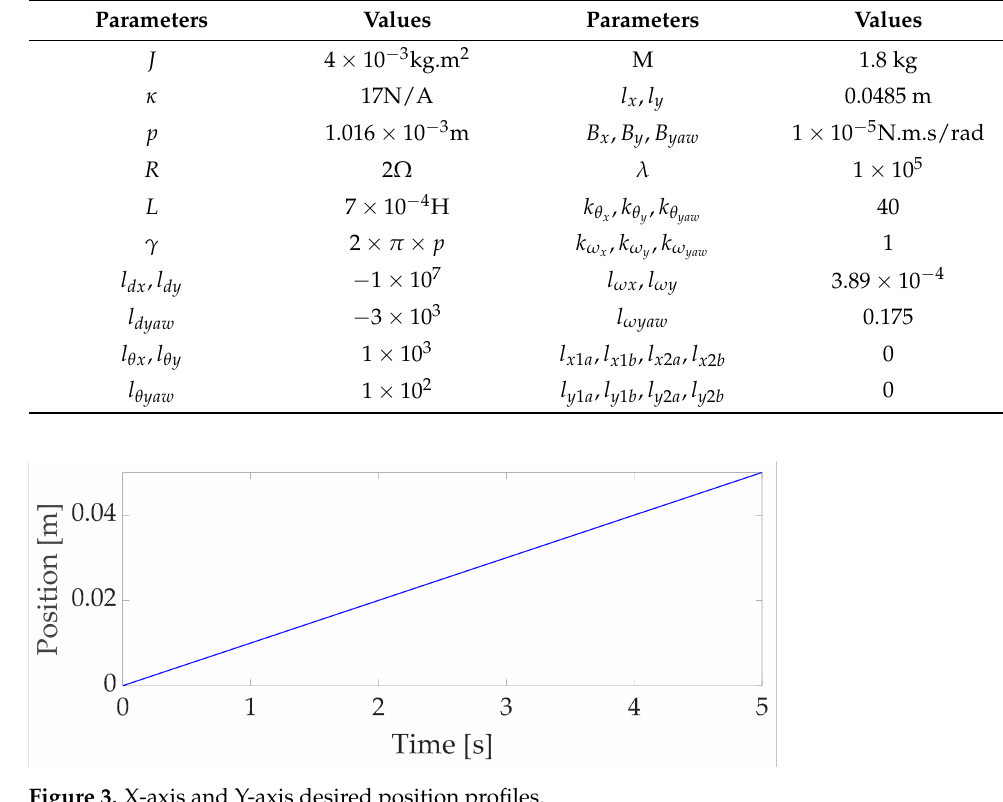
Figure 3. X-axis and Y-axis desired position